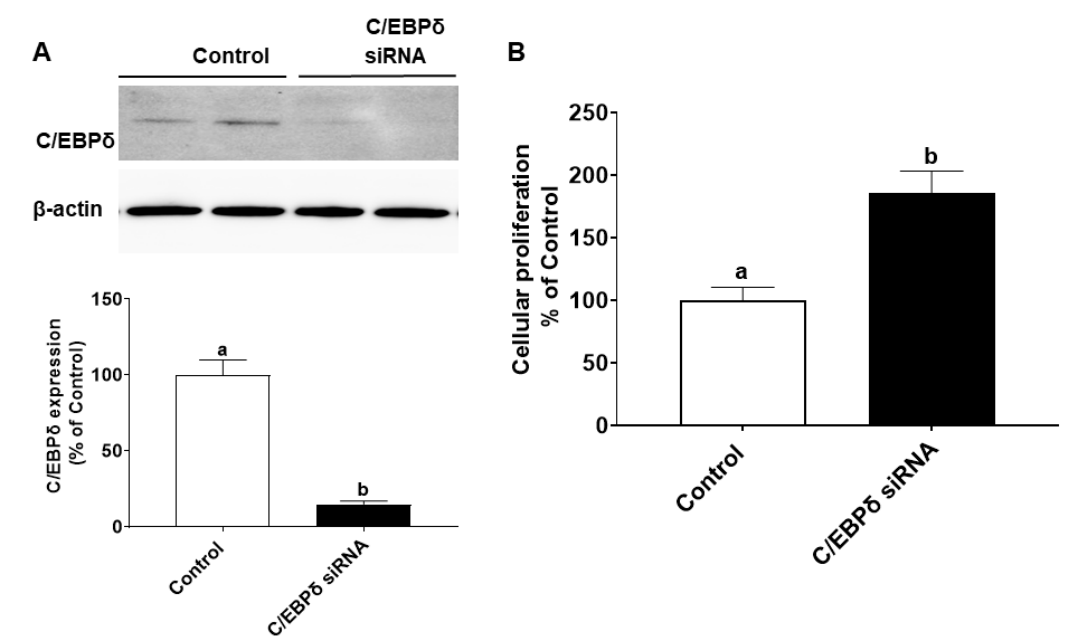
Figure 6. Effects of C/EBP δ inhibition on proliferation of HIECs. HIECs were transfected with C/EBP δ siRNA, and proliferation was then evaluated with a BrdU cellular proliferation kit (Roche). ( A ) C/EBP δ siRNA significantly inhibited the protein level of C/EBP δ . ( B ) After C/EBP δ was down- regulated, proliferation of HIEC cells was markedly increased. n = 5. Values are shown as mean ± SD, relative to the control (set to 1). Bars without a common letter are significantly different ( p < 0.05).